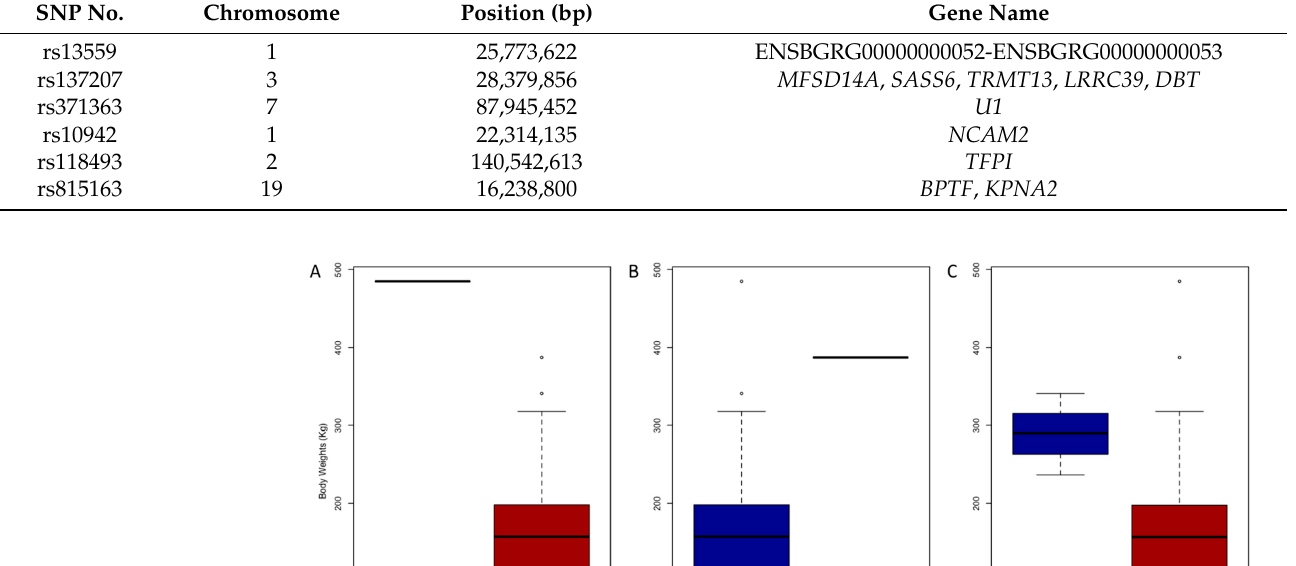
Figure 3. Manhattan plots with all genotypes with three GWAS methods. The GWAS results of three GWAS methods were integrated into circle multiple Manhattan plots ( A ). The outer ring is the marker density and the significant markers were marked as red star. The markers detected by more than two methods were drawn with gray string line. The QQ plots of multiple methods were also integrated into figure ( B ). Table 1. The candidate genes’ information of associated significant SNPs in the 200 kb region. The SNP No. indicates order number in the whole marker list. The chromosome and position mean the physical location information in the genome data. The gene names were annotated from GTF file in the BosGru_v3.0 reference genome. The values in the brackets are distance of base pair between such marker and nearest gene. Class indicates the type of gene, and the region transcribed shows the region SNPs located in.